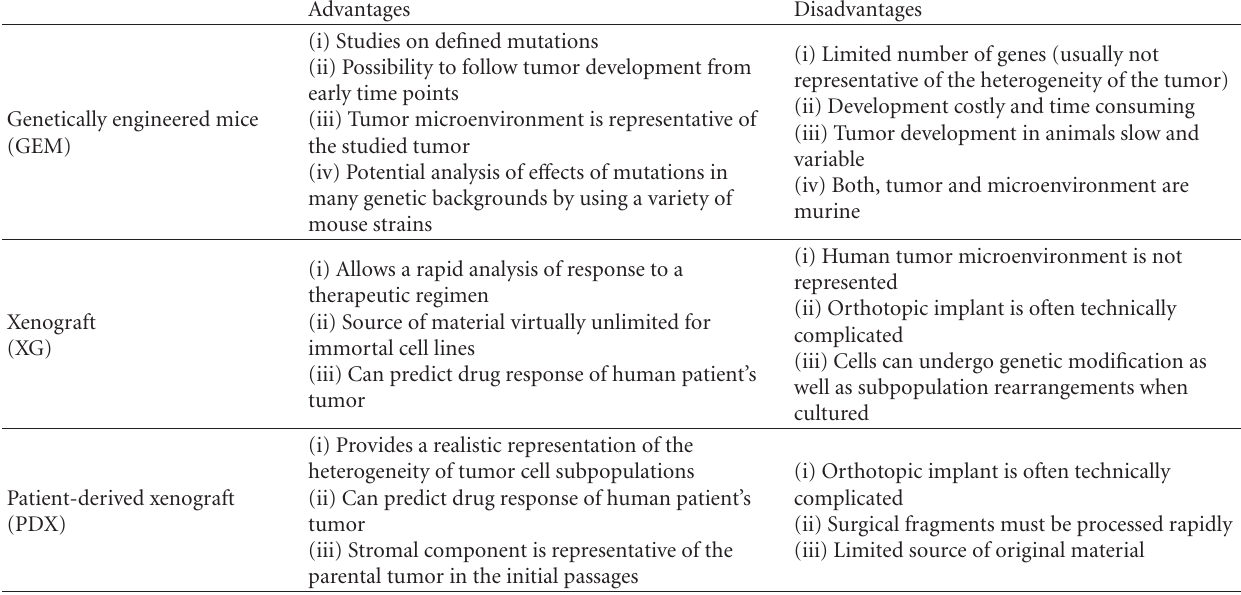
Table 1: Main advantages and disadvantages of GEM, XG, and PDX mouse